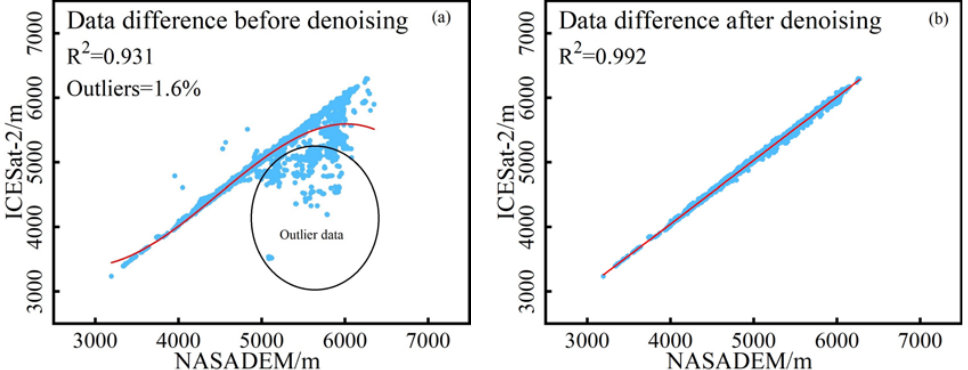
Figure 5. Results before ( a ) and after ( b ) denoising of ICESat-2 footprints. Before denoising, the points in and around the circle can be regarded as the points where the elevation of an ICESat-2 footprint is far from the datum NASA DEM. After denoising, the elevations of ICESat-2 footprints have a high correlation with the datum NASA DEM.